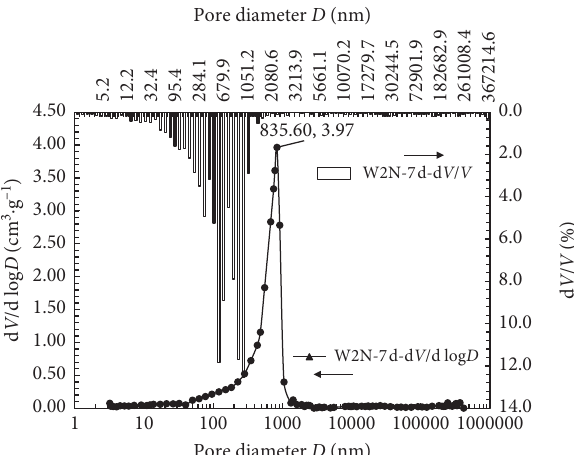
Figure 12: Pore diameter distribution of 7-day-old W2 N con- cretion by MIP test.